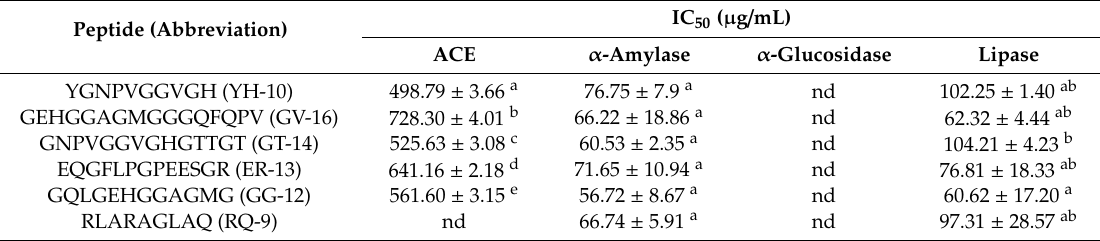
Table 2. IC 50 value of enzymes involved in metabolic syndrome pathogenesis. ACE: angiotensin- converting enzyme.